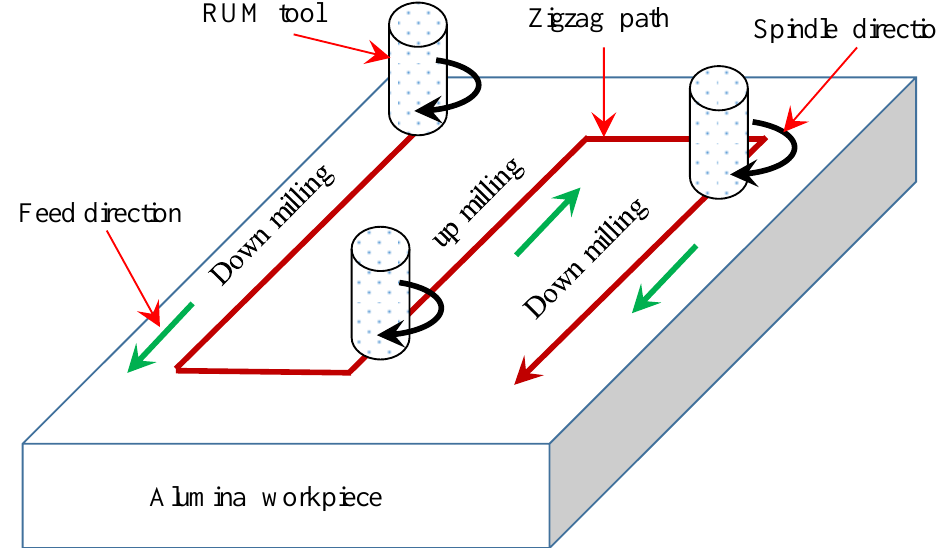
Figure 13. Schematic diagram of the Zigzag path strategy.